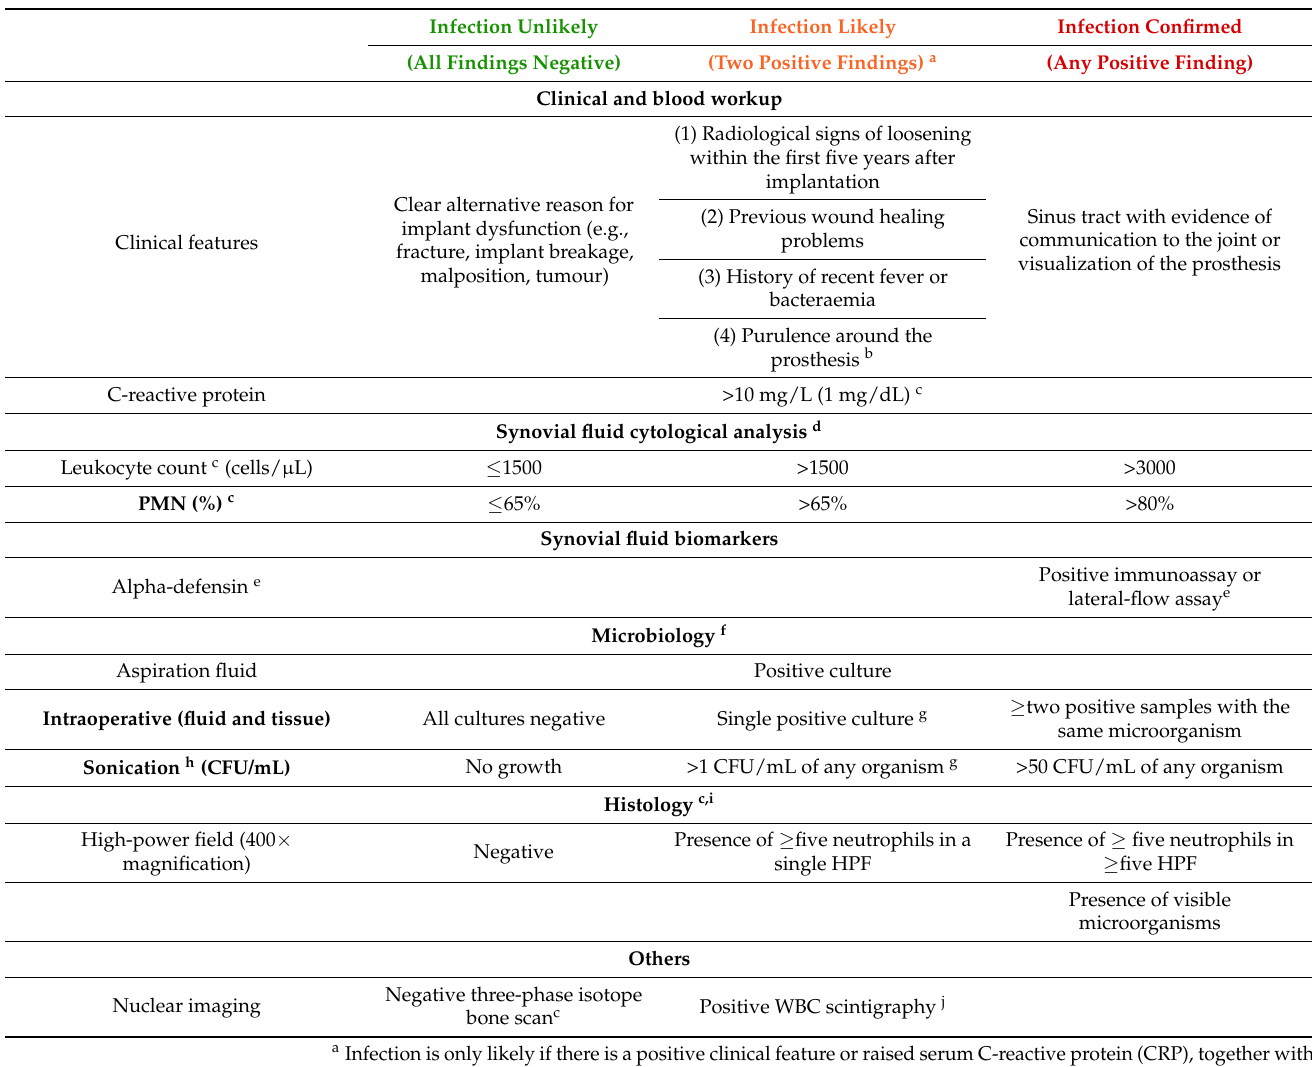
Table 1. 2021 European Bone and Joint Infection Society (EBJIS) definition for the diagnosis of periprosthetic joint infection